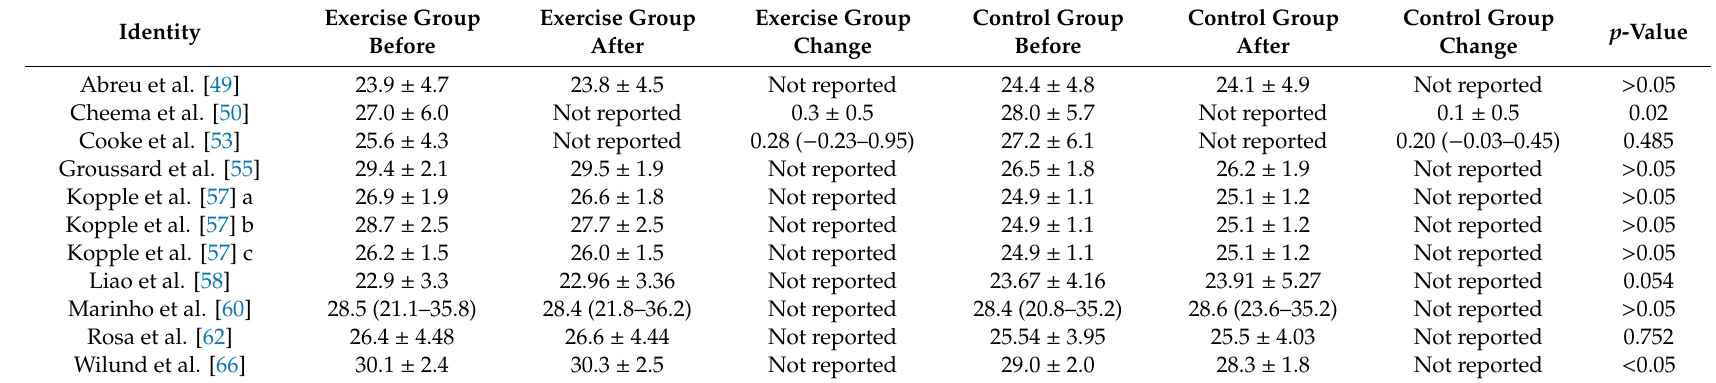
Table 2. Results on BMI after intervention.